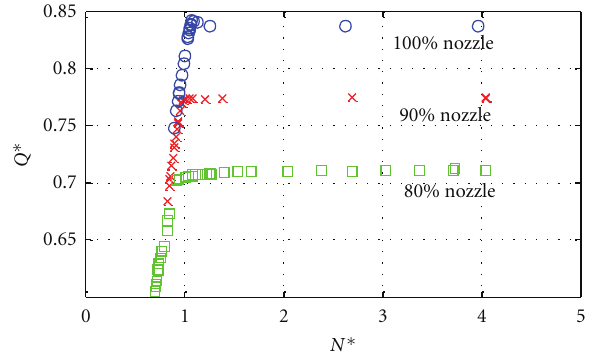
Figure 7: Experimental results [20]. Three di ff erent nozzle con- strictions were set downstream of the waterjet. 100% nozzle, 90% nozzle, and 80% nozzle. Each of the nozzle settings resulted in a di ff erent single-phase Q ∗